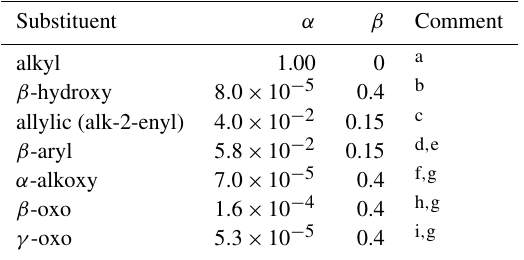
Table 12. Substituent activation factors applied to self-reaction rate coefficients, based on Eq. (17).